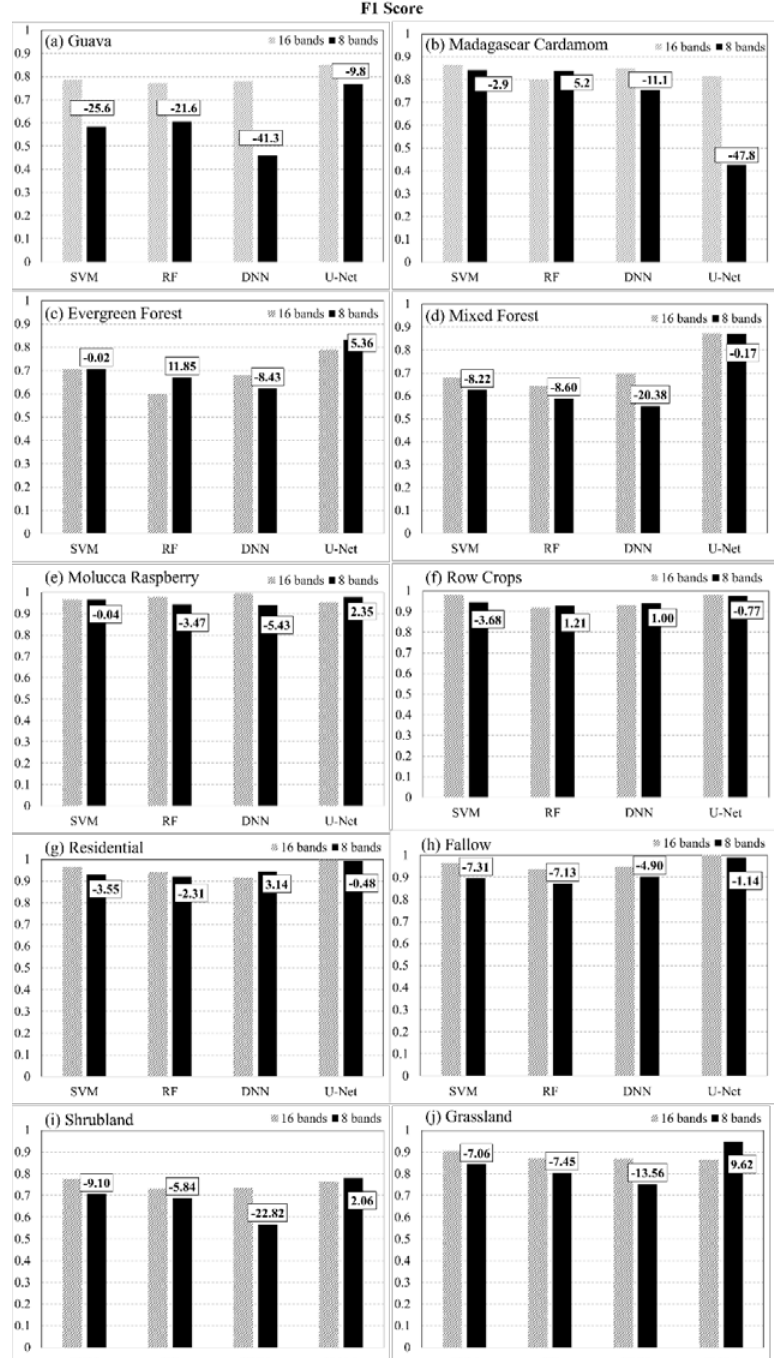
Figure 18. F1 scores of all classification methods employed including (16 bands) and excluding SWIR bands (8 bands), showing the percent change due to the removal of SWIR bands for ( a ) Guava, ( b ) Madagascar Cardamom, ( c ) Evergreen Forest, ( d ) Mixed Forest, ( e ) Molucca Raspberry, ( f ) Row Crops, ( g ) Residential, ( h ) Fallow, ( i ) Shrubland, and ( j ) Grassland.